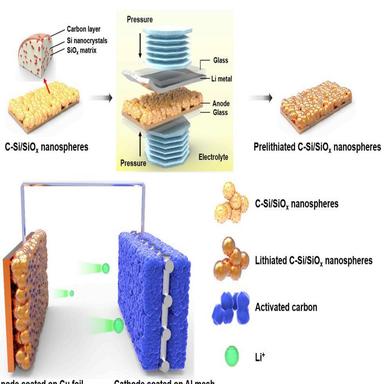
Schematic illustration of the pre-lithiation process for preparing the pre-lithiated C-coated Si/SiOx nanosphere electrode.